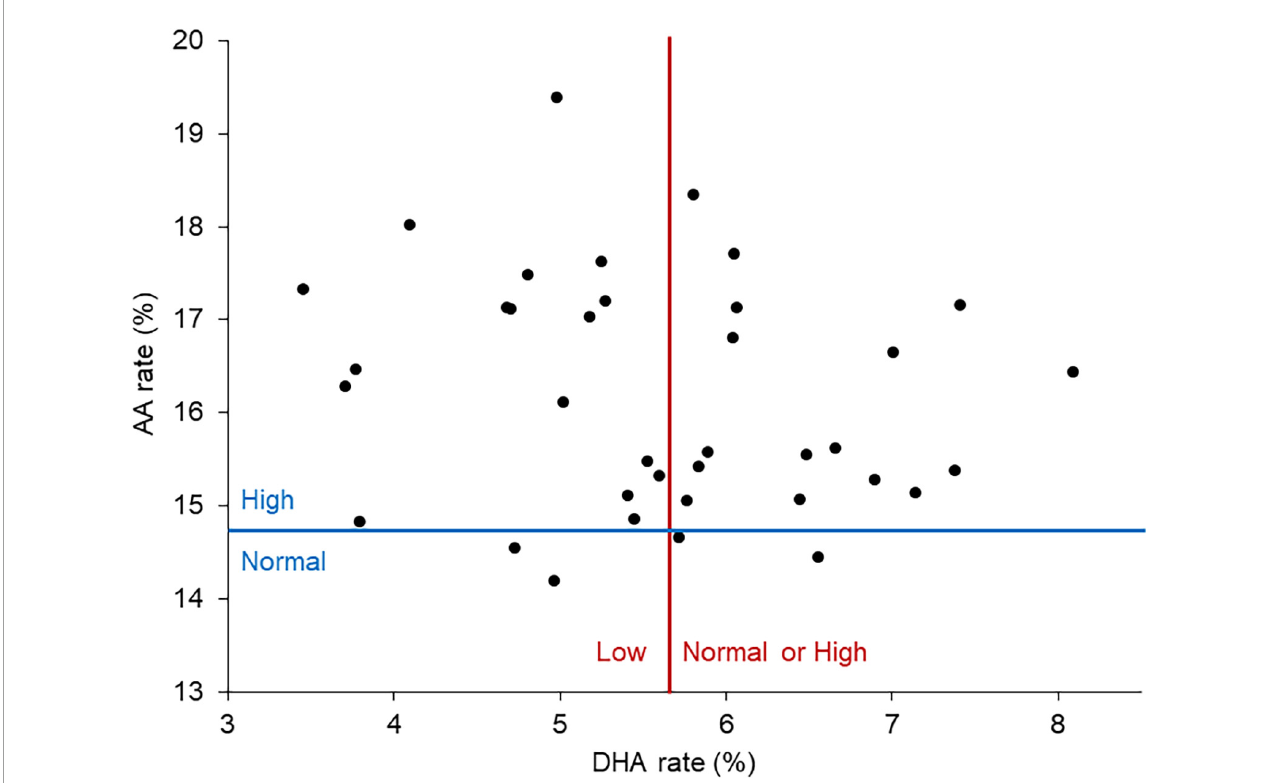
FIGURE1 DHA and AA rates among patients. The red line corresponds to the threshold between low and normal or high DHA rates. The blue line corresponds to the threshold between normal and high AA rates. Almost all patients had an elevated AA level. Patients were divided in two groups of comparable size based on their DHA level: DHAn corresponding to a normal or high DHA rate and DHA– corresponding to a low DHA